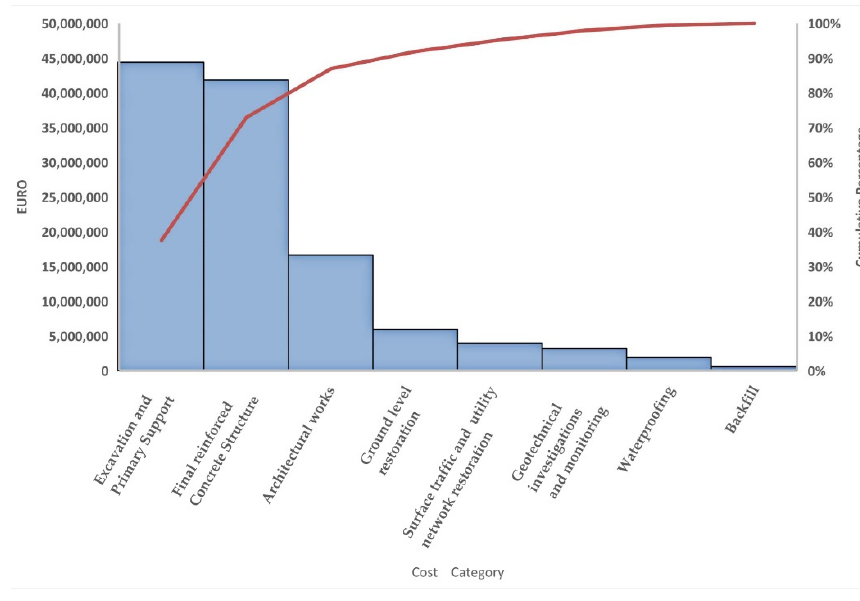
Figure 6. Distribution of TCEC.